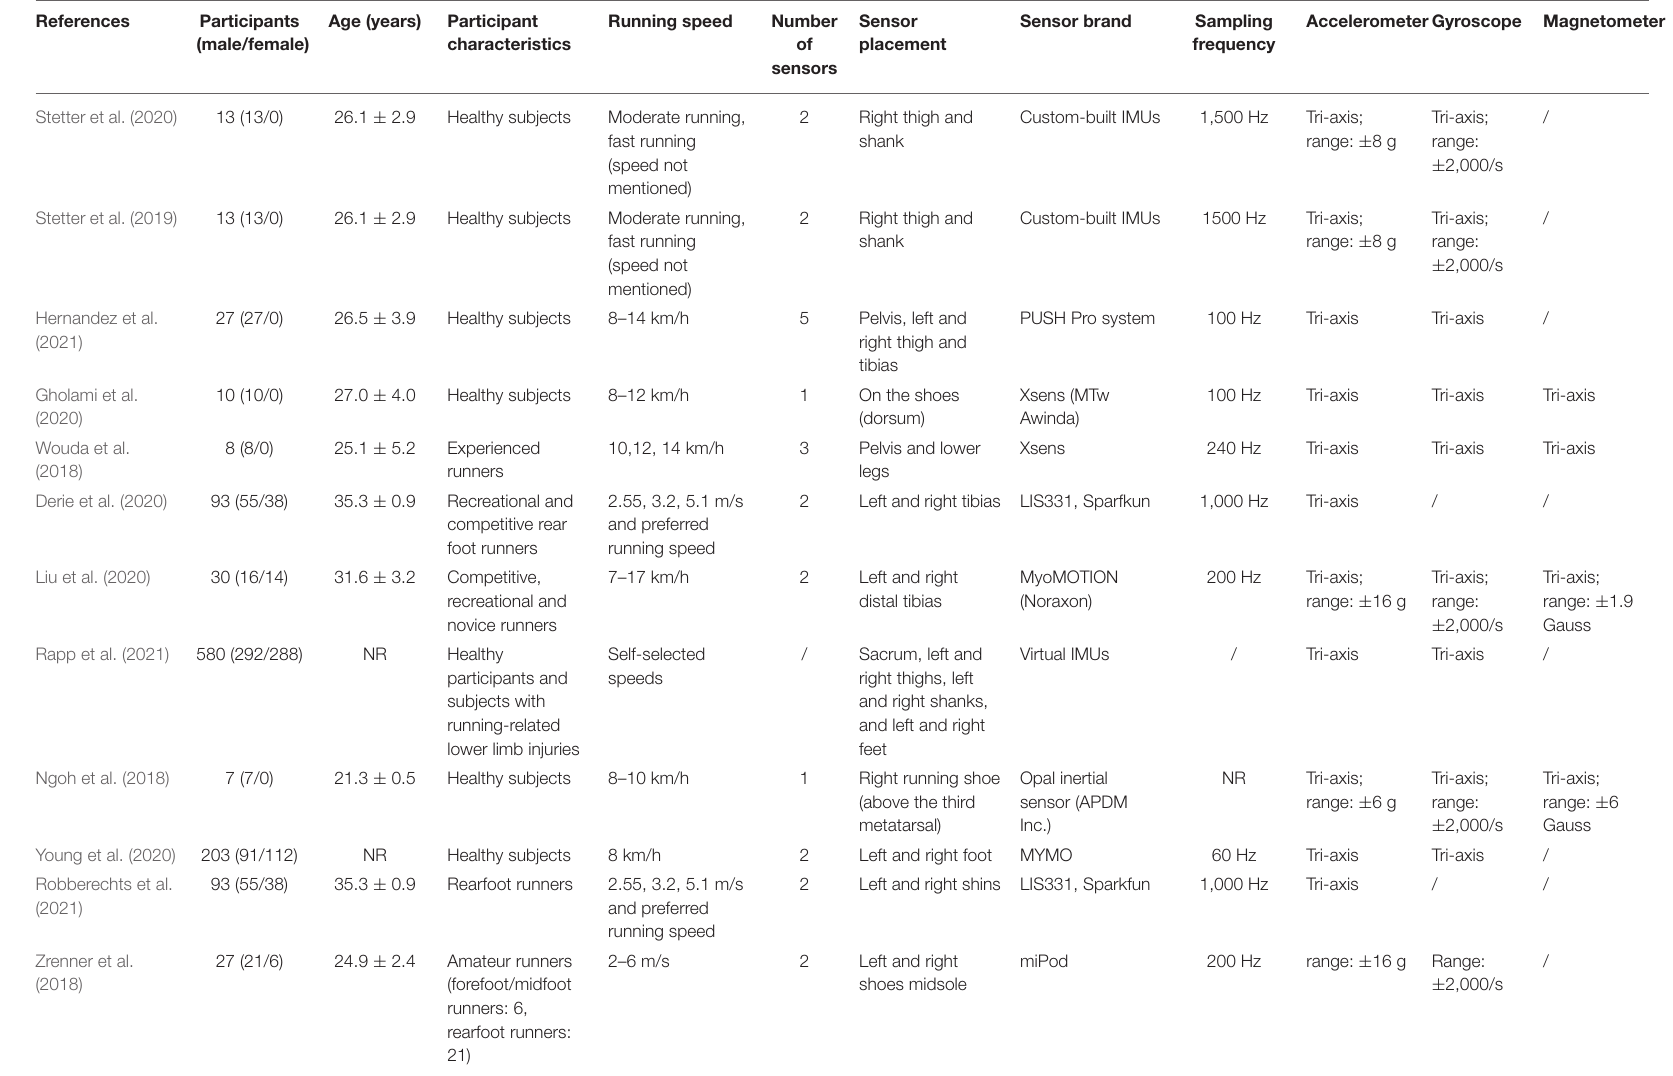
TABLE 3 | Participants and wearable inertial sensor